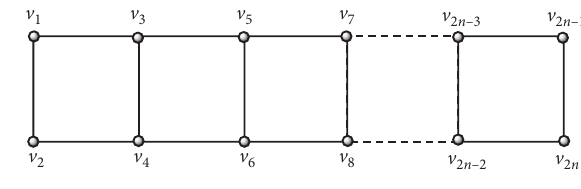
n . Figure 2: Ladder graph L